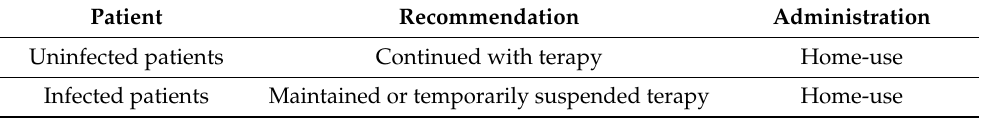
Table 1. Recommendations for the use of biologics during COVID-19